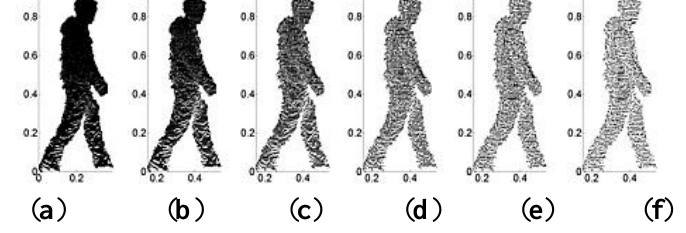
Figure 3. Simplification of point cloud data: ( a ) raw data; ( b ) ε = 10 −6 ; ( c ) ε = 10 −5